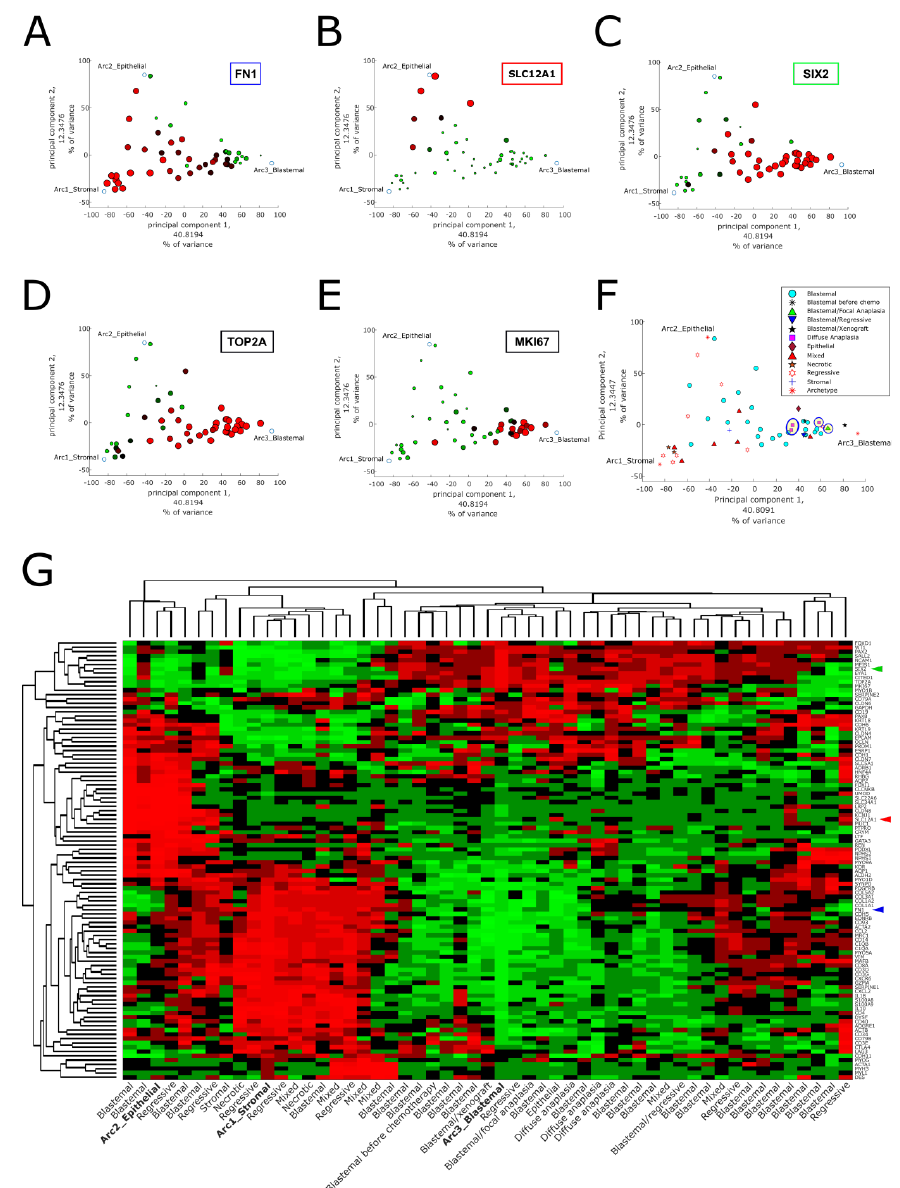
Figure 1. Pareto task inference shows that blastemal type, post-operative chemotherapy Wilms’ tumors fill a triangle shaped continuum in latent space that is bounded by archetypes with stromal, epithelial, and blastemal characteristics. ( A – E ) Shown are PCA plots of the tumors in our dataset along with the three calculated archetypes (the vertexes of the triangle). In order to identify the archetypes, in each panel we selected a gene marking one of the three main lineages of the fetal developing kidney and plotted the size and color of each point according to its expression level (red large—high expression, green small—low expression). It can be seen than FN1 , a marker for the un-induced mesenchyme, is highly expressed towards the stromal archetype. Likewise, SLC12A1 , which marks the renal epithelium, is highly expressed near the epithelial archetype, and SIX2 , a marker for the cap mesenchyme, is predominantly expressed near the blastemal archetype. The genes TOP2A and MKI67 , which mark cycling cells, are also highly expressed near the blastemal archetype. ( F ) A PCA plot of the tumors marked according to their reported histological type. It can be seen that tumors with anaplastic histology (diffuse or focal), which is considered least favorable, tend to